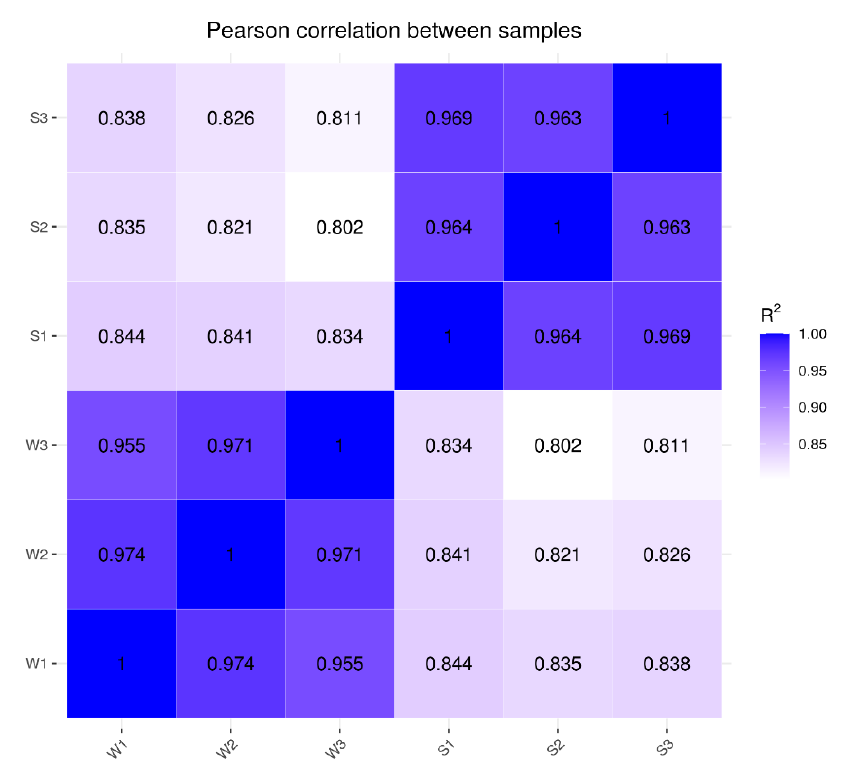
Figure 4. Heatmap of correlation coefficient. Note: W: Wan1314-6, S: Shangshu19. According to the RNA-seq results (Table 1), the average base sequencing error rate of the library sequencing data was around 0.03; the percentage of bases with Phred values greater than 20 in the overall bases ranged from 96.99% to 97.67%, and the percentage of bases greater than 30 in the overall bases ranged from 92.00% to 93.64%. The results showed high sequencing quality, and most clean reads were retained for further analysis. Table 1. Evaluation of the quality of sweetpotato Wan1314-6 and Shangshu19 blades sequencing